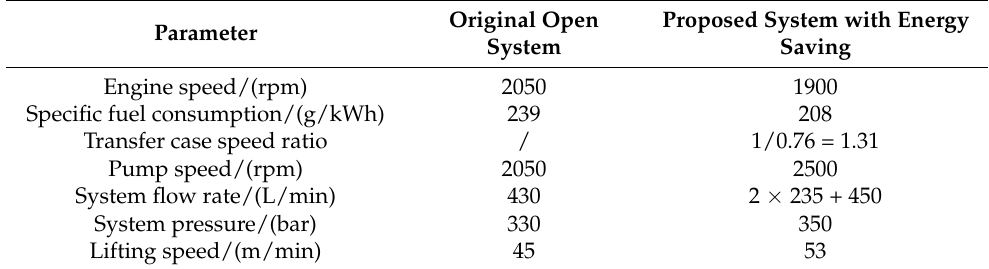
Table 1. Parameters match of the two systems.